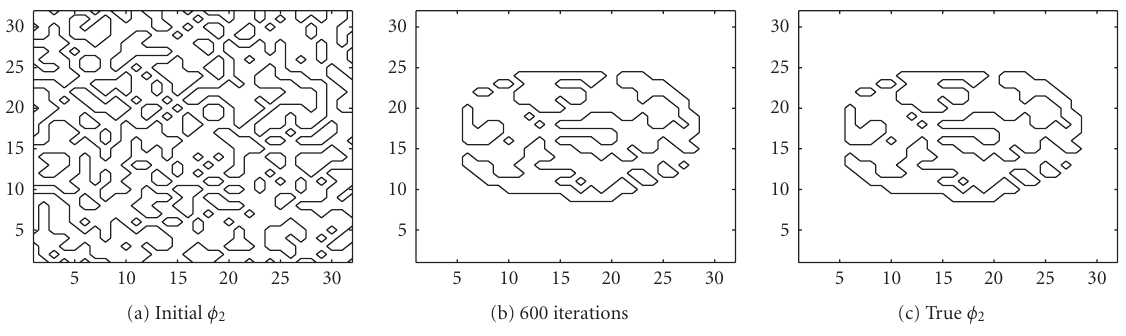
Figure 9: Interfaces given by the zero level set of the function φ 2